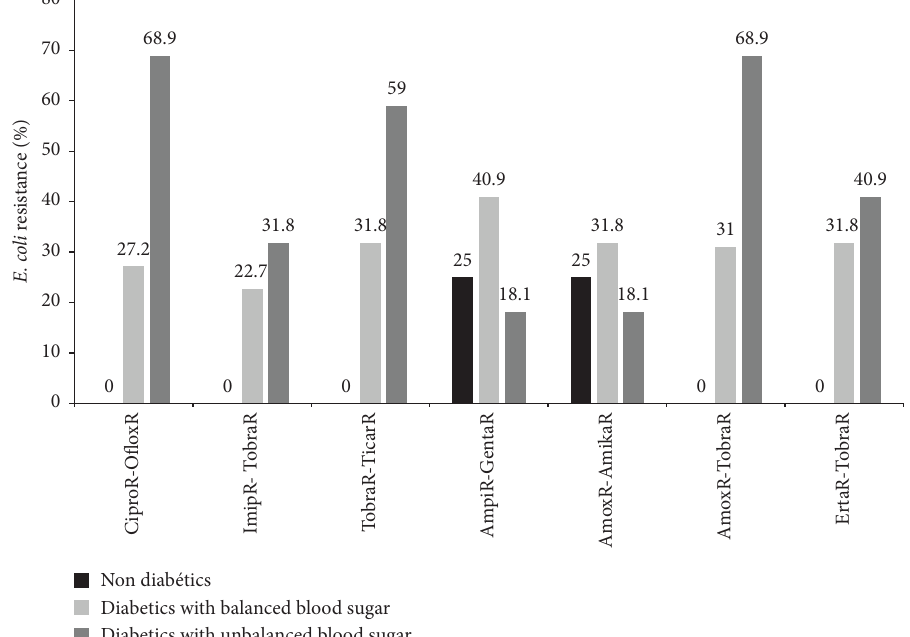
Figure 3: Distribution of E. coli resistance to double antibiotics as a function of diabetic status. Amika: amikacin, Amox: amoxicillin, Ampi: ampicillin, Cipro: ciprofoxacin, Genta: gentamicin, Ofox: ofoxacin, Erta: ertapenem, Ticar: ticarcillin, Tobra: tobramicin, Imip: imipenem, Nitro: nitrofurantoin, and R: